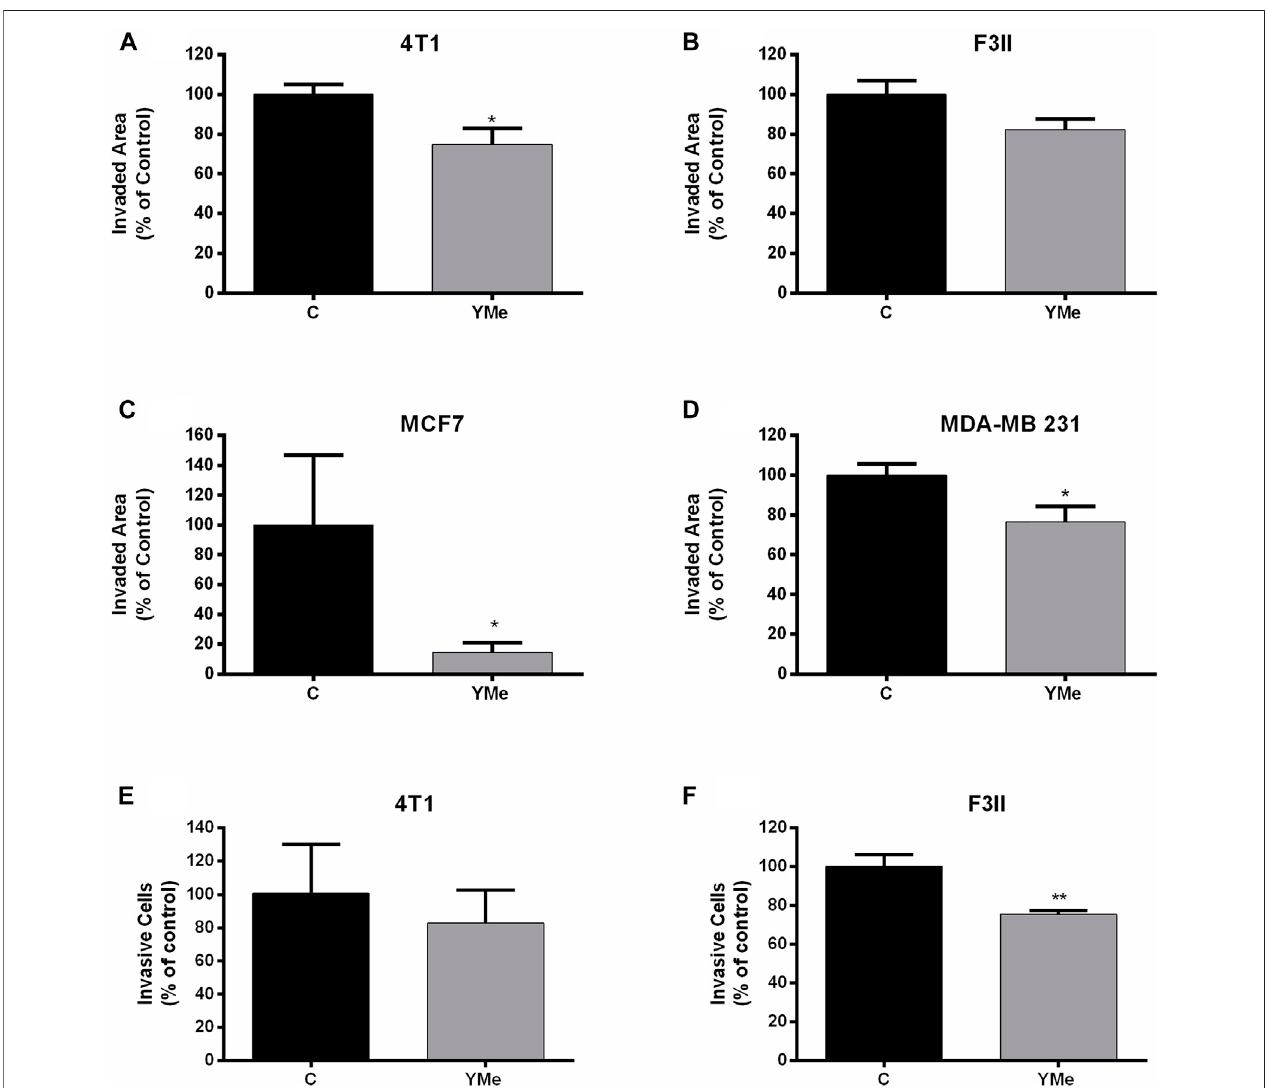
FIGURE4| EffectofYMeoncellmigrationandinvasion.YMeinhibitedthecellmigrationof4T1,F3II,MCF-7andMDA.MB231( A,B,C,D respectively).BCcelllines were cultured to 85% con fl uence in a 6-well plate and the cell layer was scratched with a yellow micropipette tip. Cells were incubated in the presence of YMe for 12 h. Before and after incubation, images were photographed using an inverted microscope (Nikon, NIS elements software) (40X magni fi cation). Quanti fi cation of wound closure distance was made. Values are expressed as mean ± SEM. * p < 0.05, Student ’ s t test. To examine the effect of YMe on the ability of cells to move in a chemoattractant gradient, a transwell invasion assay was used. 4T1 and F3II cells ( E,F respectively) were suspended in serum-free medium and seeded in the upper chamber of transwells. Following incubation with YMe for 24 h, invaded cells were stained with crystal violet and counted under an inverted microscope (Nikon, NIS elements software) (40X magni fi cation). Data are expressed as the mean ± SEM (n (cid:2) 3). Three independent experiments were performed. ** p < 0.01 vs . control cells, Student ’ s t test.